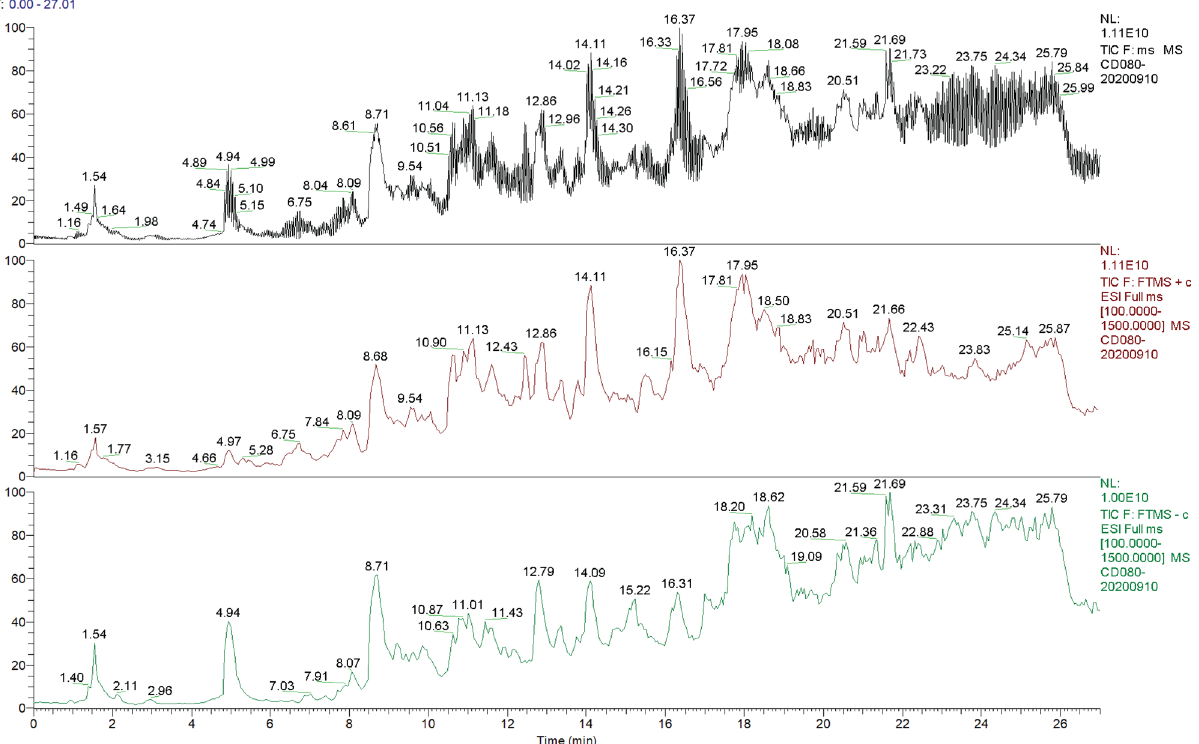
Figure 1. Total ion flow diagram of WFEA. Column 1, column 2 and column 3 respectively show the superposition of positive and negative total ion flow diagram in black, the total ion flow diagram in positive ion mode in red, and the total ion flow diagram in negative ion mode in